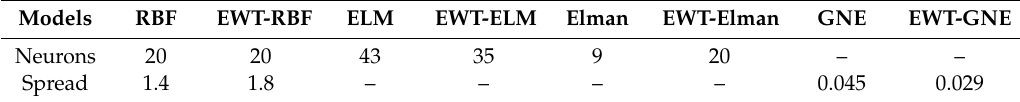
Table 1. Optimal parameters of the ANN models used for streamflow forecasting.